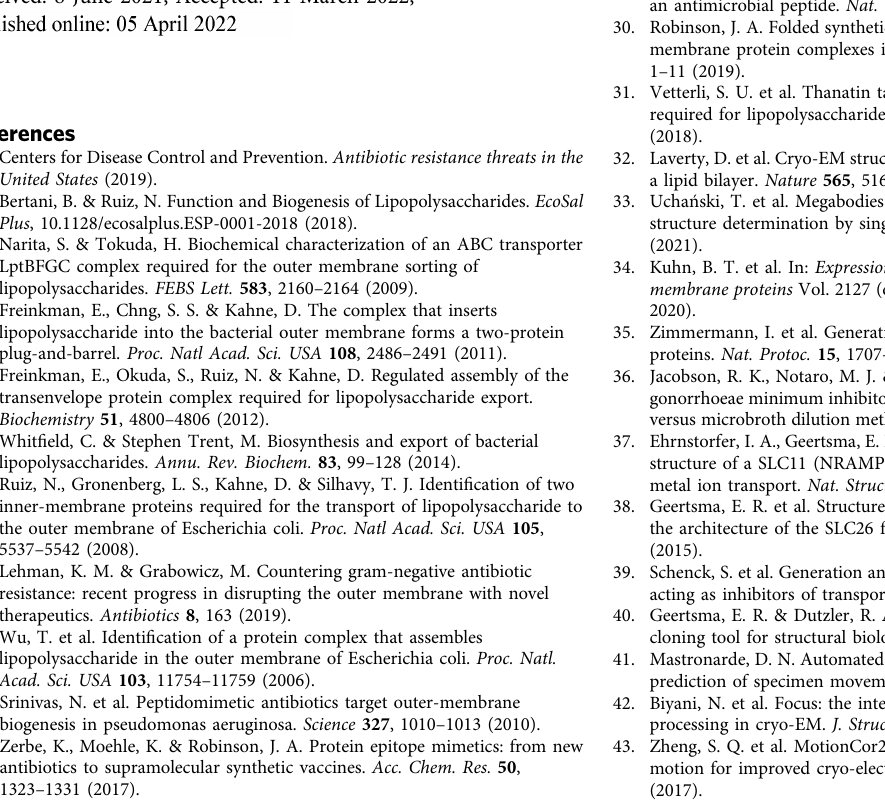
Figure preparation . Figures were prepared using the programs Chimera X (http:// www.rbvi.ucsf.edu/chimerax/ 54 ), Chimera (http://www.cgl.ucsf.edu/chimera/ 48 ), PyMOL (http://www.pymol.org/) and Schrödinger